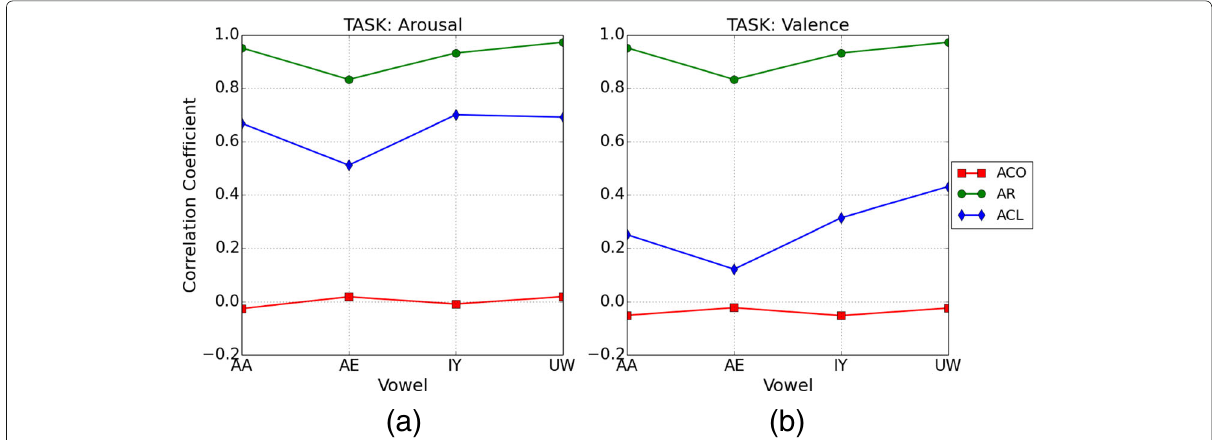
Fig. 6 A comparison of the average correlation coefficient over all articulatory targets and speakers under different training criteria for the USC EMA